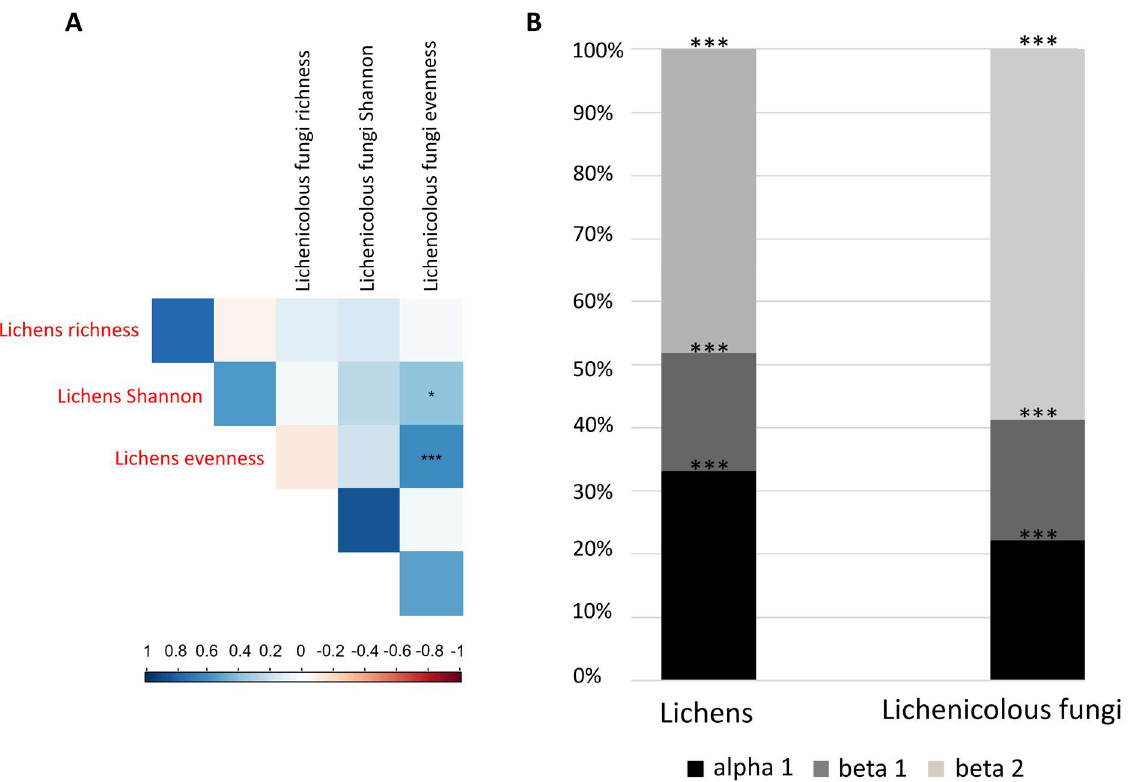
Figure 3. ( A ) Correlation indices matrix: significant correlations are marked with black asterisks (*** = p -value < 0.001, ** = p -value < 0.01, * = p -value < 0.05); squares colours correspond to cor.mtest correlation coefficient values; colours are related to the test score. ( B ) Additive diversity partitioning among taxa at three hierarchical spatial levels: sampling site level (subplot, in black), sampling area level (plot, in dark grey), and study area level (light grey). Both α1 and β1 indicate α and β at a sampling site, respectively; β2 denotes β at the area level. *** = p -value < 0.001, ** = p -value < 0.01, * = p -value < 0.05.